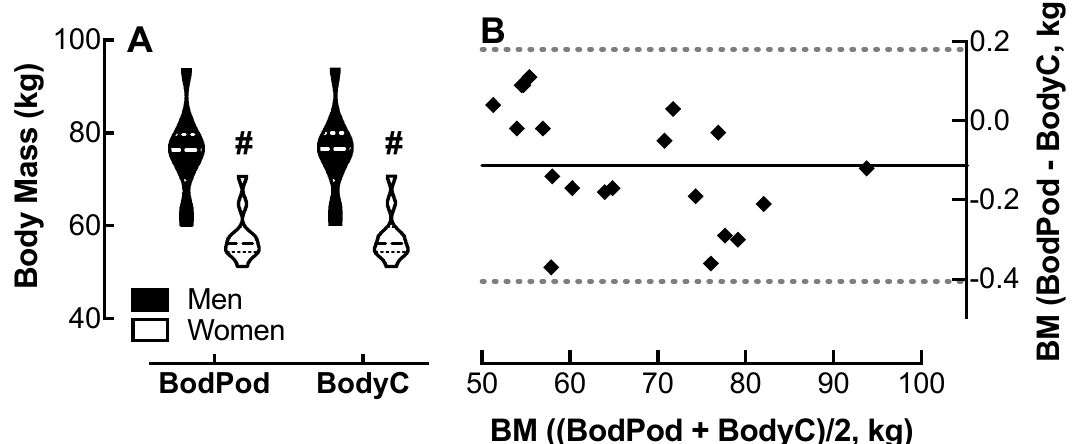
Figure 3. Comparison of body mass (BM) measured by the Body Cardio with Bod Pod determinations. ( A ) Violin plot of BM measured by the Bod Pod and BodyC in men and women; p < 0.01, male vs. female by two-way ANOVA; n = 10/group. ( B ) Q-Q plot of BM determined by the Bod Pod and BodyC. Each data point represents duplicate or triplicate measures in one study participant. BM, body mass.